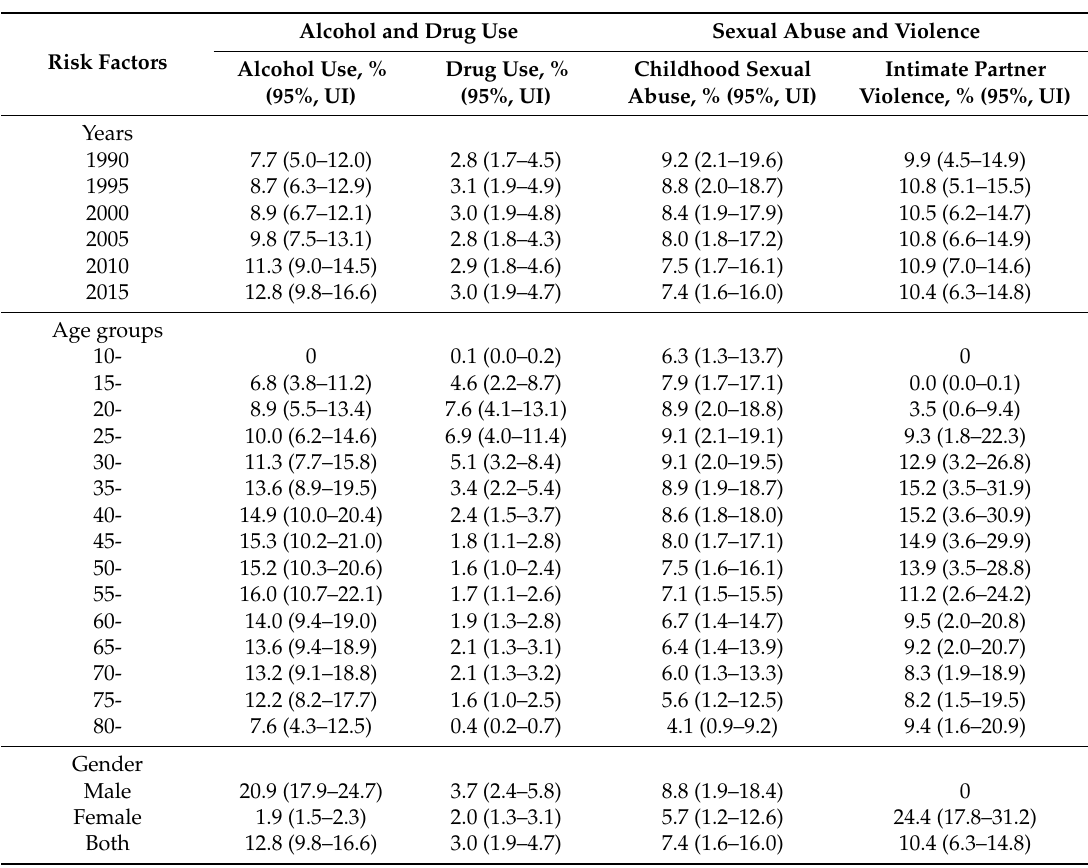
Table 3. Percentage of total DALYs from risk factors for self-harm by year, by 5-year age intervals and by gender in Hubei,